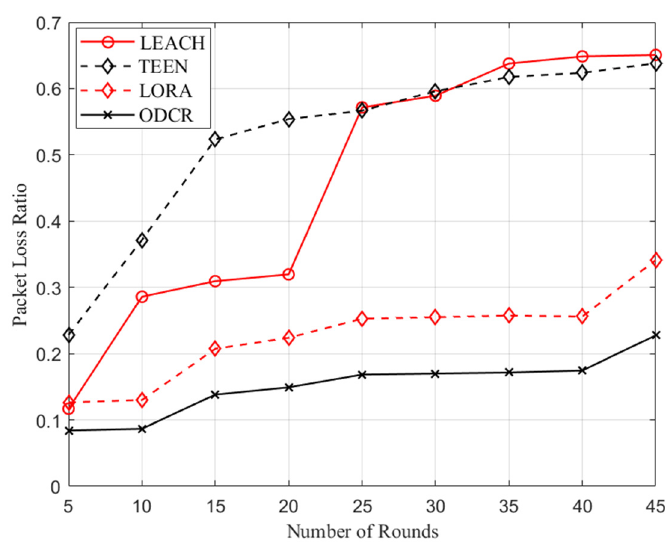
Figure 9. Comparison of packet loss ratio.